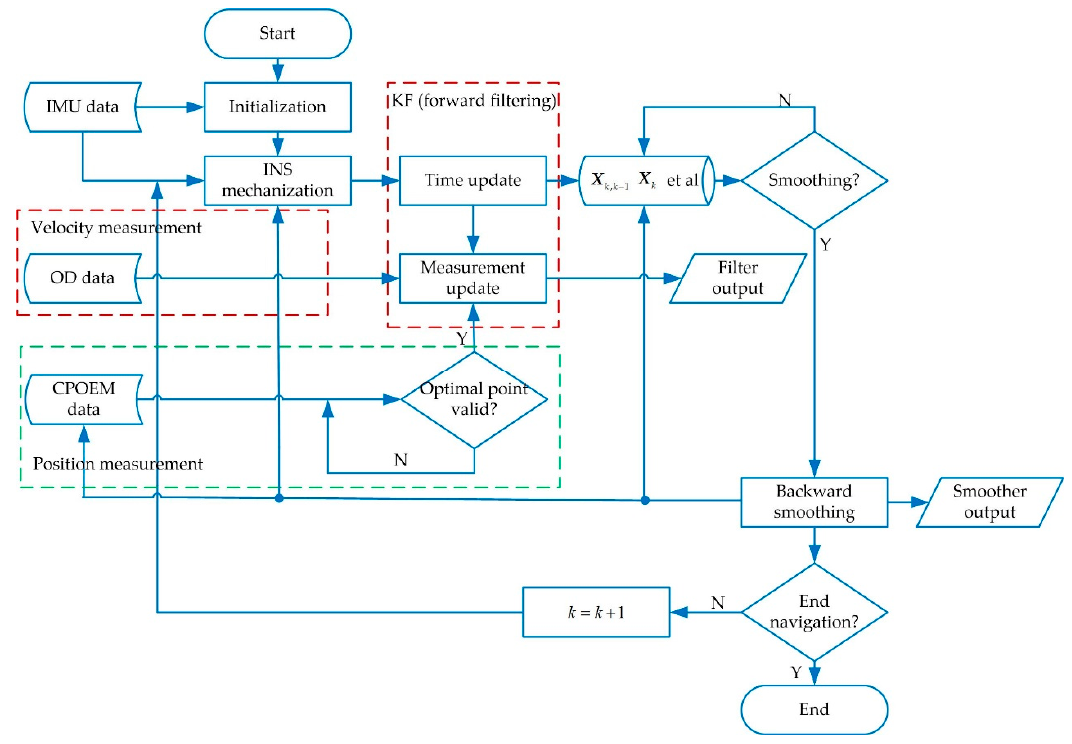
Figure 4. Flowchart of KF and the RTS smoother.